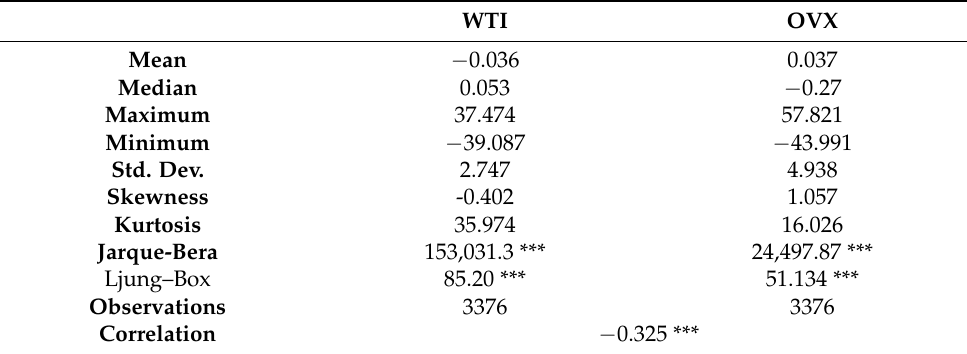
Figure 1 . Evolution of daily levels and returns of WTI crude oil and OVX. Figure 1. Evolution of daily levels and returns of WTI crude oil and OVX. Table 1. Summary statistics of returns series for WTI and